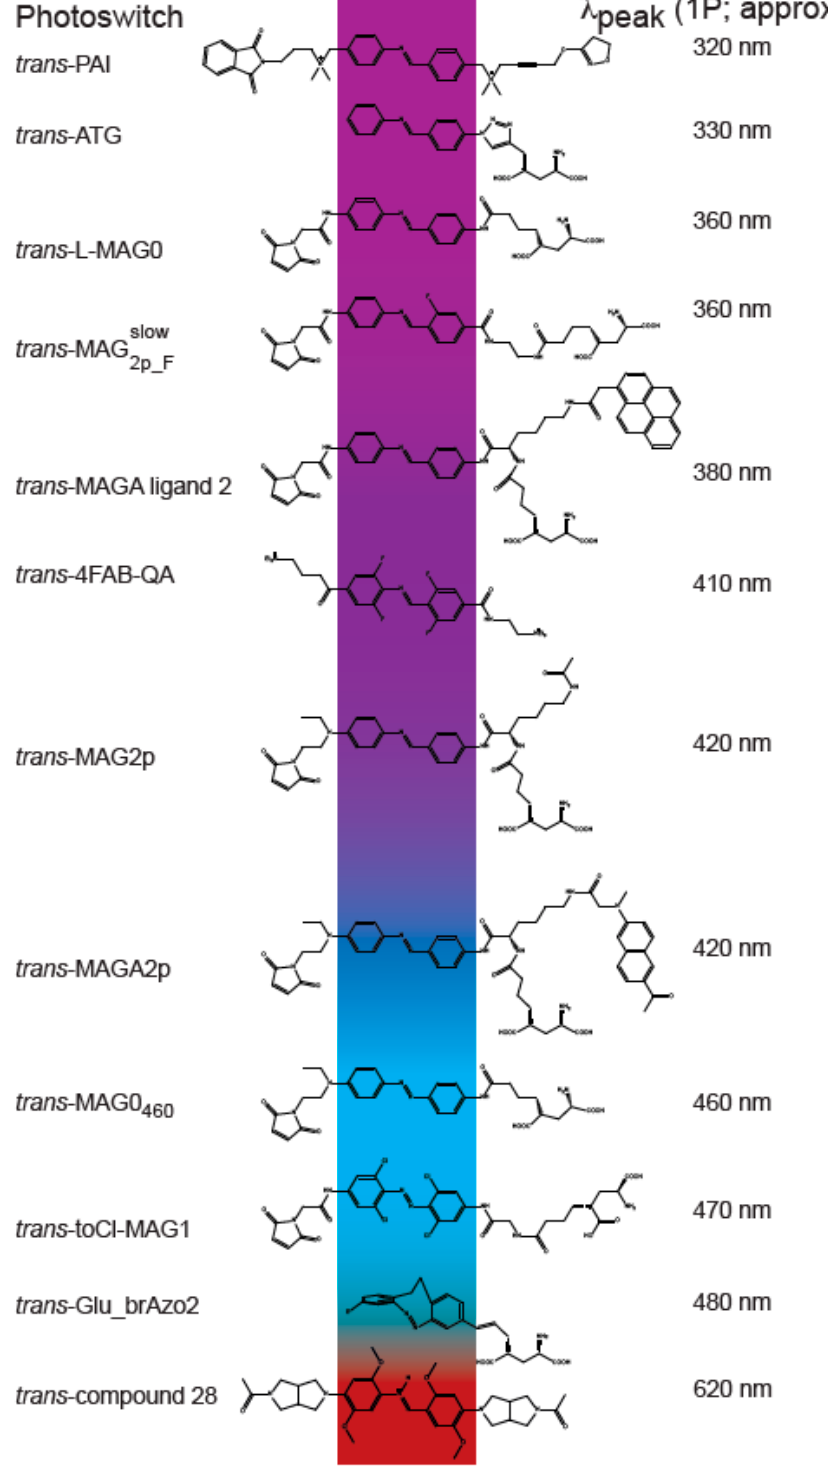
Figure 3. Chemical structure and absorption of exemplary 2P-compatible photoswitches. Left, names of photoswitches; right, one photon (1P) peak absorption ( λ max ), also depicted by middle color gradient.